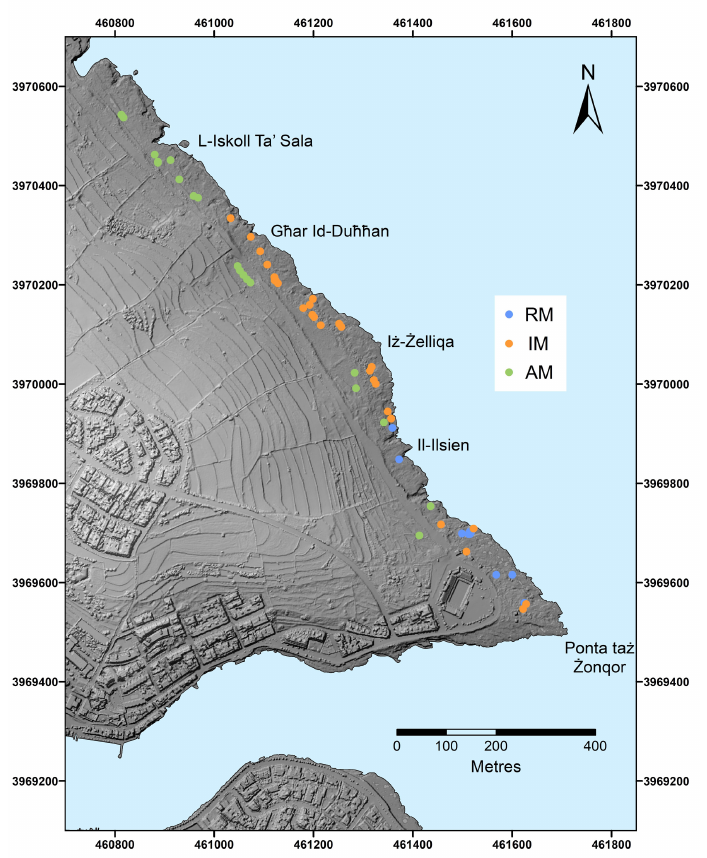
Figure 6. Distribution of boulders of interest (BOI), illustrating locations of recent movers (RM), indeterminate movers (IM) and ancient movers (AM). Hill shading is based on LiDAR at 1 m pixel